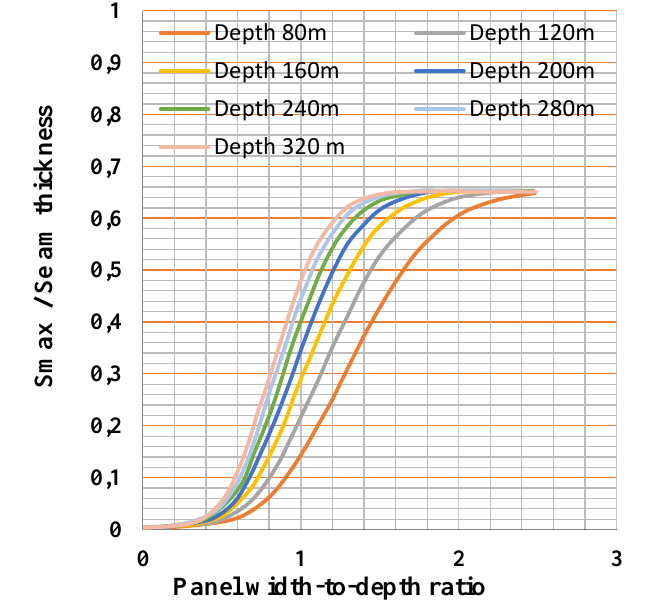
Figure 5: Subsidence profiles obtained using the incremental profile